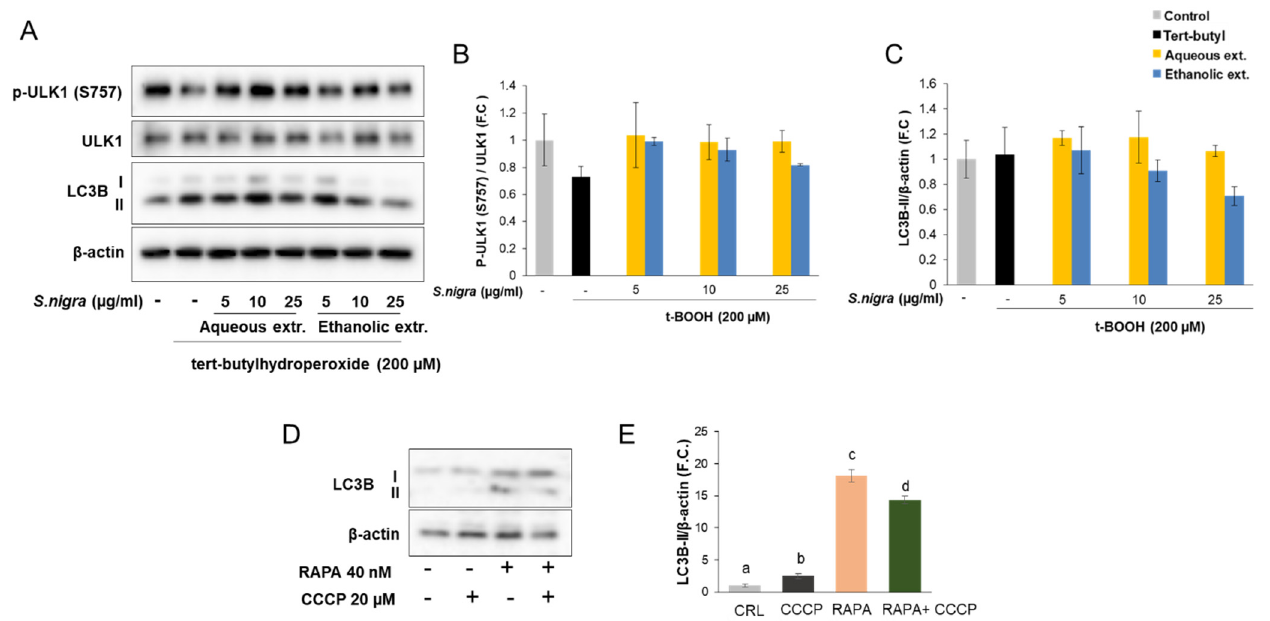
Figure 6. ( A – C ) Pre-incubation of SH-SY5Y cells with aqueous or ethanolic extracts from S. nigra flowers modulates autophagy in response to oxidative stress induced by tert-butylhydroperoxide treatment (200 µM, 30 min). ( D , E ) Western blots from SH-SY5Y cells treated with the mitochondrial uncoupler CCCP for 2 h in the presence or absence of 40 nM of rapamycin for 24 h, with densitometric quantification LC3-II. We used rapamycin (RAPA) as a positive control to stimulate autophagy. Values are means ± SD, n = 3. Values are expressed as a percent relative to activity of control condition. Different letters indicate statistically significant differences ( p < 0.05) among groups.